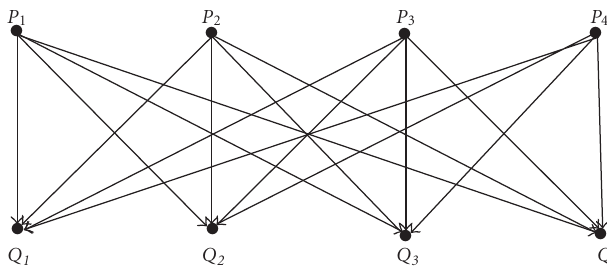
Figure 1: Network structure of the numerical dynamic spatial oligopoly